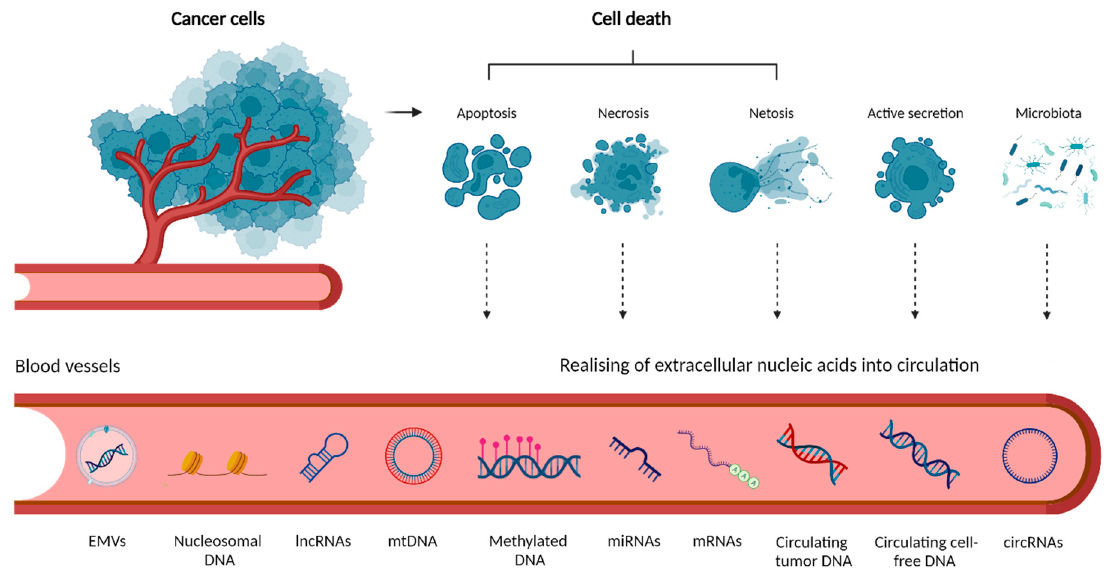
Figure 1. Origin of extracellular nucleic acids in circulation. Tumor cells release extracellular cfNAs through a combination of (i) cell death such as apoptosis, necrosis, and netosis or (ii) active secretion. Circulating bacterial DNA (cbDNA) may also be detected in blood samples from cancer patients. The loss of membrane integrity in necrosis results in releasing intracellular contents, including fragments of DNA, into the circulation. In netosis, activated neutrophils release neutrophil extracellular traps, webs of chromatin, and mitochondrial DNA (mtDNA). cfDNA may exist in the peripheral blood as either free or linked to proteins in the form of nucleosomal DNA, or associated with extracellular membrane vesicles (EMVs) such as exosomes or microvesicles secreted by cells. Methylated DNA and various types of RNA are present as well (created with Biorender.com, accessed on 21 July 2022). Table 2. List of cfDNA/ctDNA biomarkers in mutation analysis and CRC management.